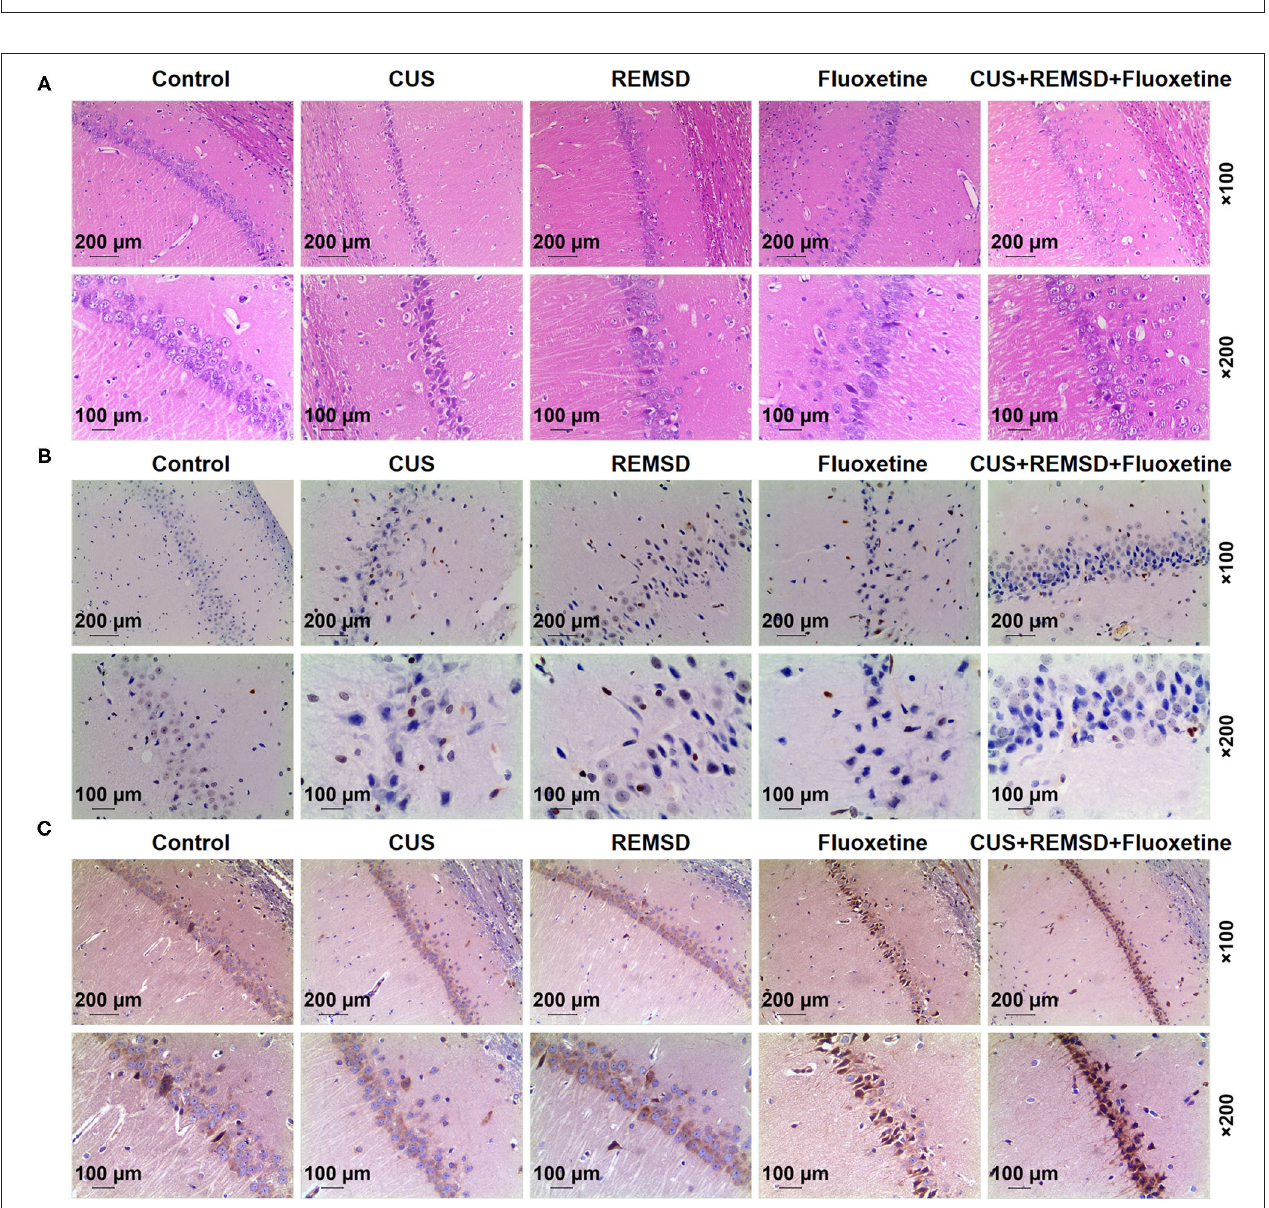
FIGURE 1 | field test. (H, I) Latency and space exploration time of rats in control, CUS (depression), REMSD, fluoxetine, and REMSD + fluoxetine groups were measured using Morris water task. *** P < 0.001, vs. control; # P < 0.05, ## P < 0.01, ### P < 0.001, vs. CUS; ∧∧∧ P < 0.001, vs. REMSD; & P < 0.05, &&& P <